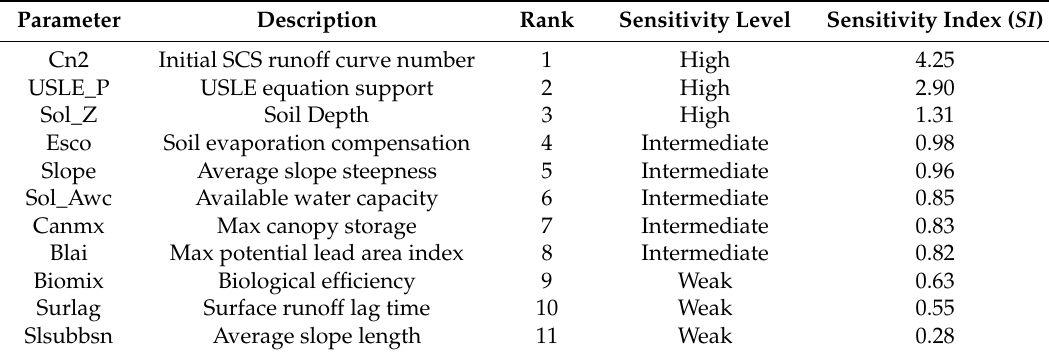
Table 2. Result of sensitivity analyses.